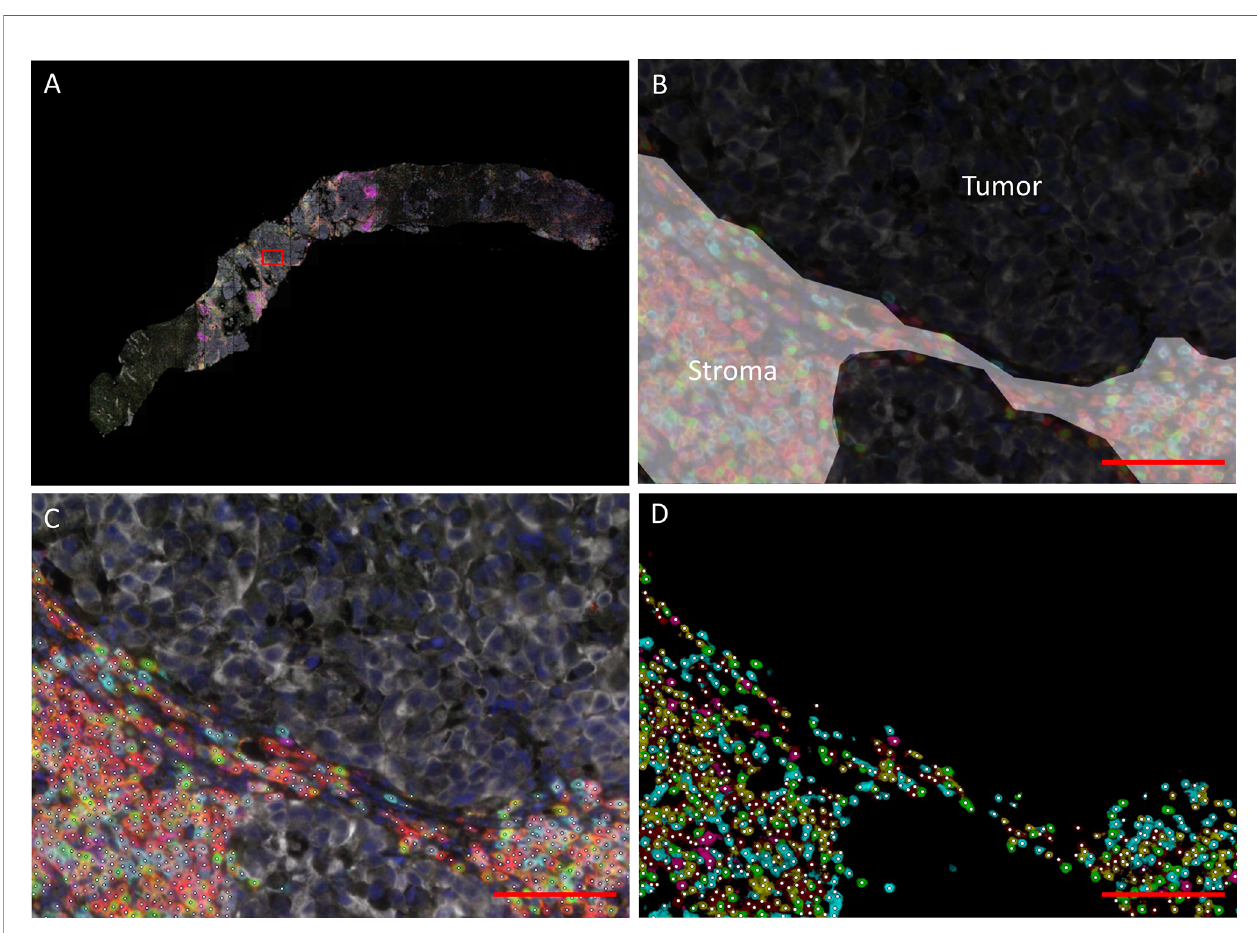
FIGURE 1 | Data processing and analysis of mIHC images. (A) Overview of a biopsy after spectral unmixing by PerKinElmer inForm ® image-analysis. The rectangle indicates the region depicted in (B – D) (B) Tissue segmentation by PerkinElmer inForm. An algorithm was trained based on the expression of pan cytokeratin, DAPI and auto fl uorescence to discriminate between tumor (black) and stroma (white). C/D. Cell segmentation (C) and phenotyping (D) . A neural network was trained to identify T cells and B cells (white dots) based on the expression of the seven immunohistochemistry markers (red = CD3; cyan = CD8; green = FoxP3; magenta = CD20; yellow = CD45RO; white = tumor marker; dark blue = DAPI). The scalebar represents a distance of 100